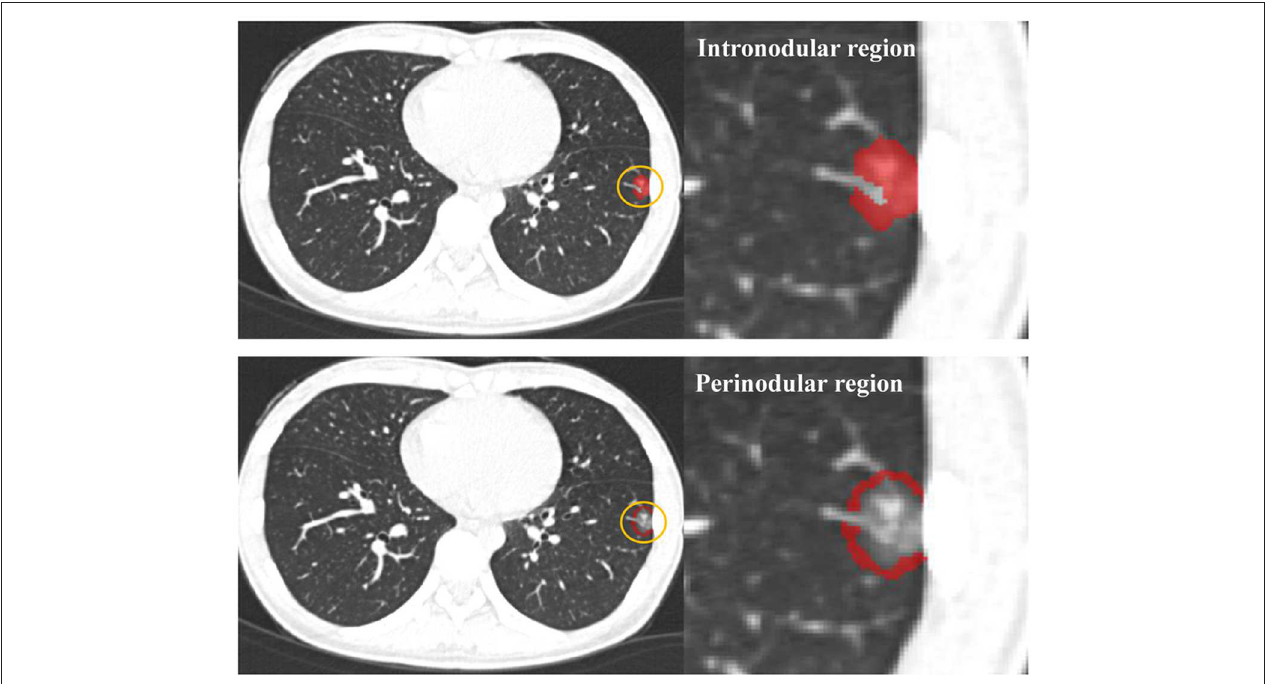
FIGURE 1 | The intra-nodular region and the peri-nodular region (the ring 2mm region) were drawn on an axial image.